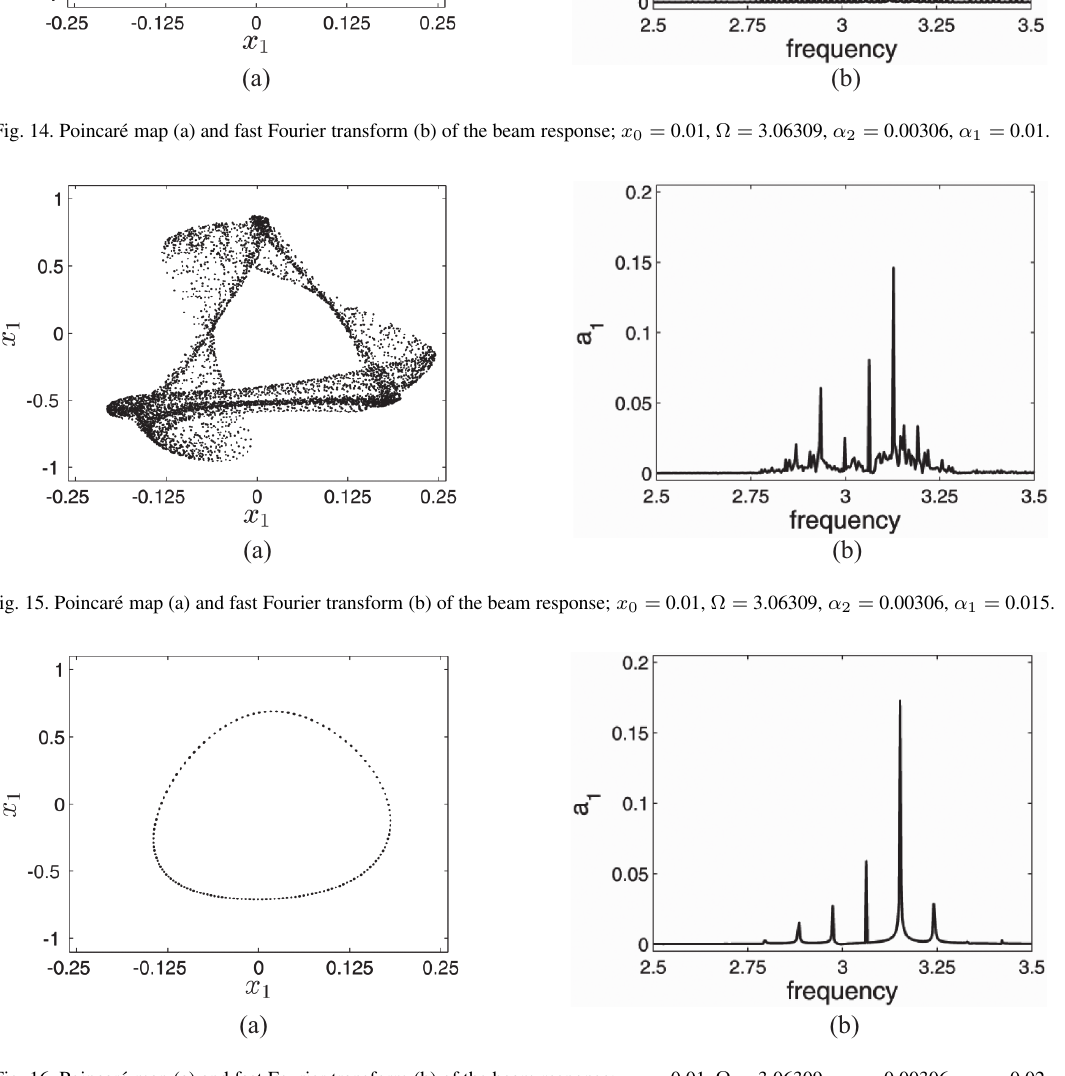
Fig. 16. Poincaré map (a) and fast Fourier transform (b) of the beam response; x 0 = 0.01, Ω = 3.06309, α 2 = 0.00306, α 1 = 0.02. for the amplitude of excitation x 0 = 0.01 and negative damping for α 1 = 0.005. It is clearly visible that the